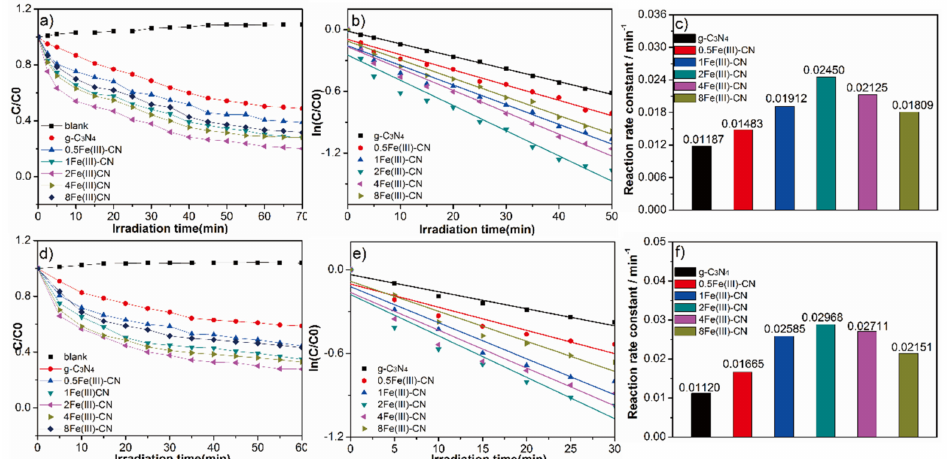
Figure 10. ( a ) Photodegradation rate of MO under visible light irradiation; ( b ) kinetic curves for the photocatalytic degradation of all samples; ( c ) reaction rate constant for the MO degradation; ( d ) photodegradation rate of TC under visible light irradiation; ( e ) kinetic curves for the photocatalytic degradation of all samples; ( f ) reaction rate constant for the TC degradation.